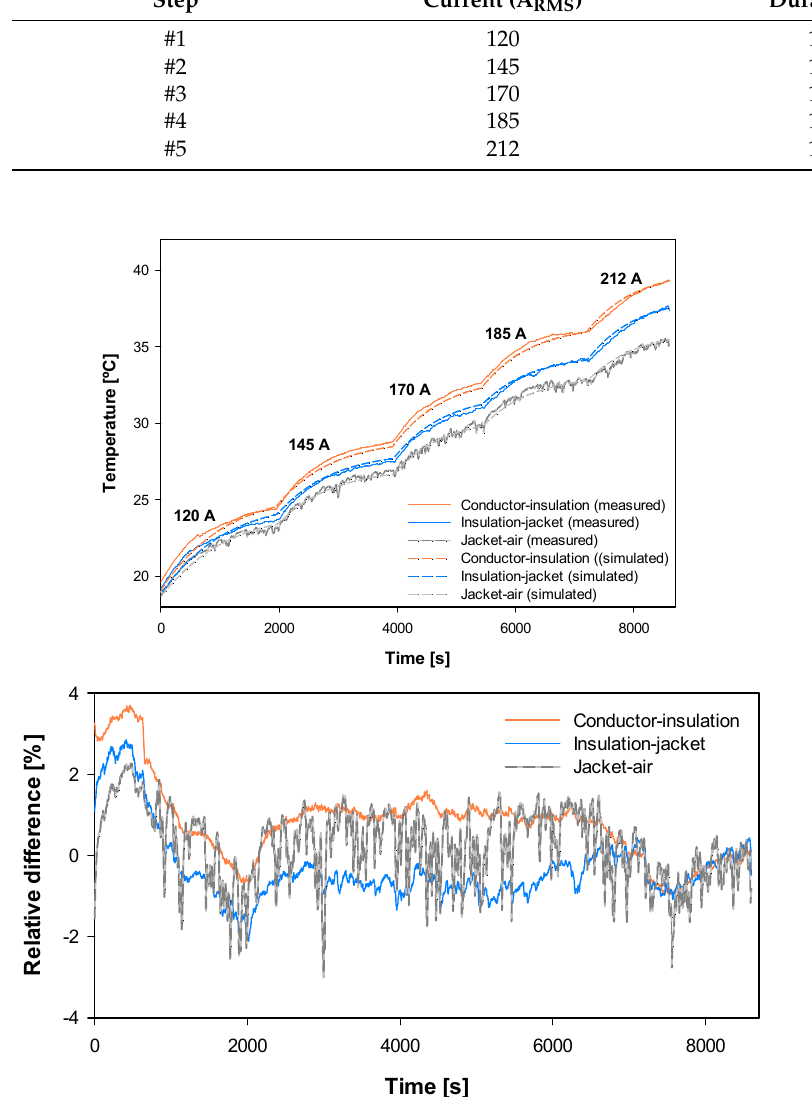
Figure 9. Conductor of 70 mm 2 . Experimental versus simulated temperature rise profiles in the three measured points of the cable (conductor-insulation boundary, insulation-jacket boundary and jacket-air boundary) and the relative difference between the experimental and simulated temperatures.